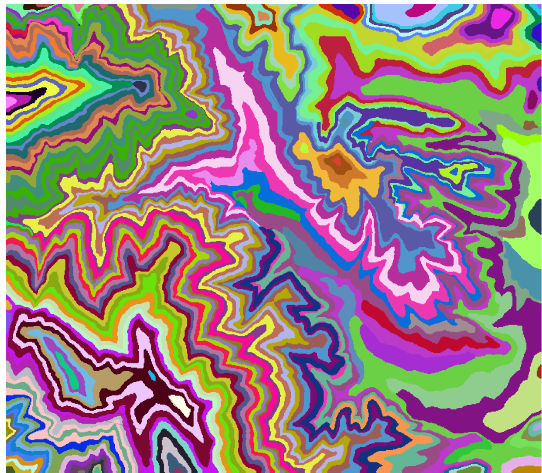
Figure 2. Grown contour line